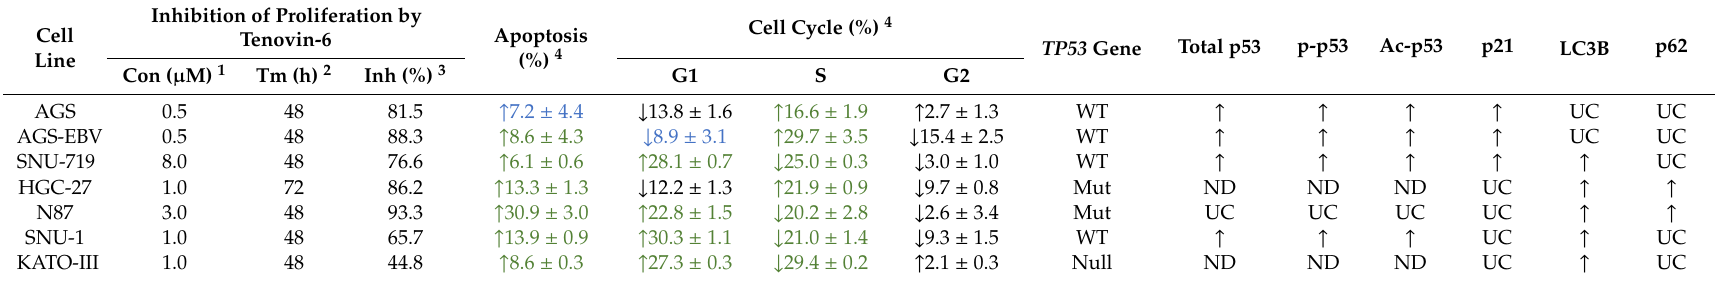
Table 1. Summary of the e ff ects of Tenovin-6 on gastric cancer cell